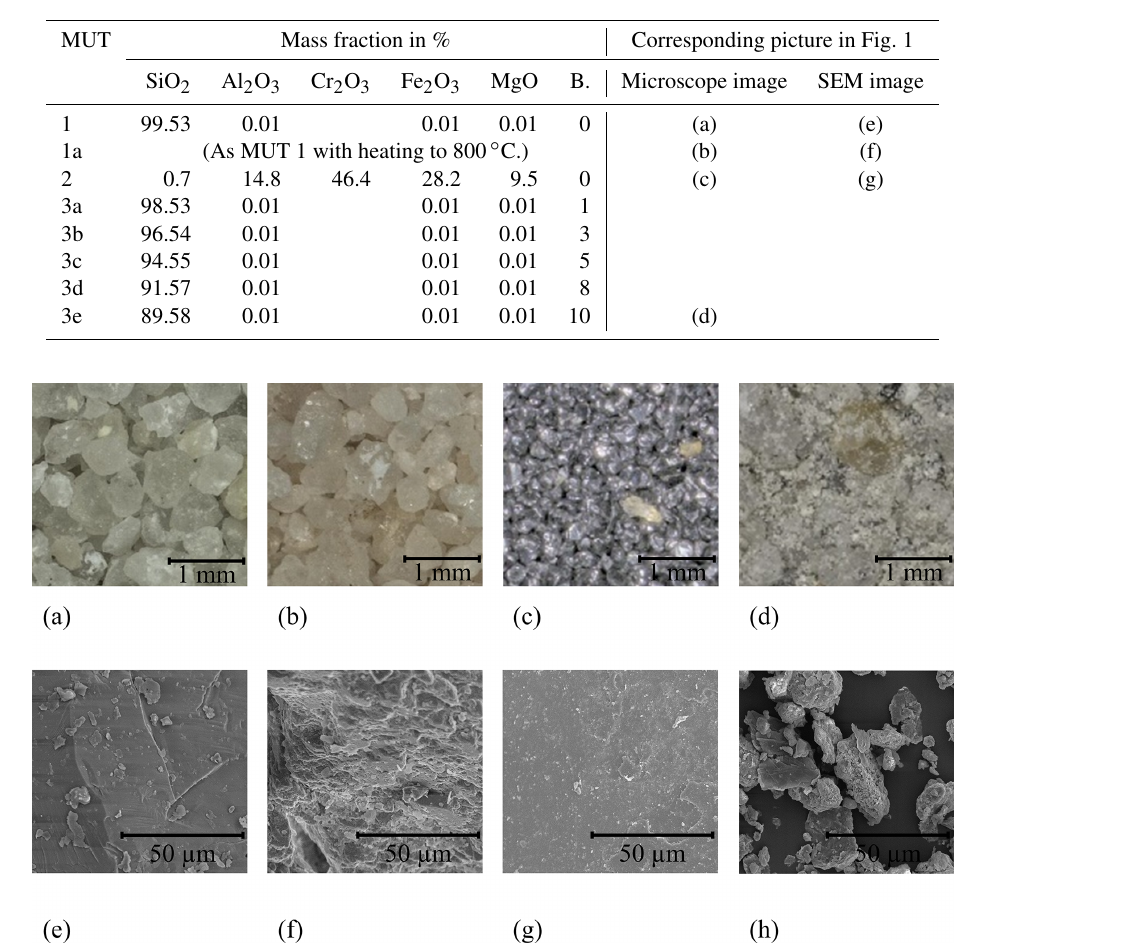
Table 1. Chemical composition (percentage mass fractions) and corresponding picture in Fig. 1 for the examined types of material under test (MUT). B. denotes bentonite.